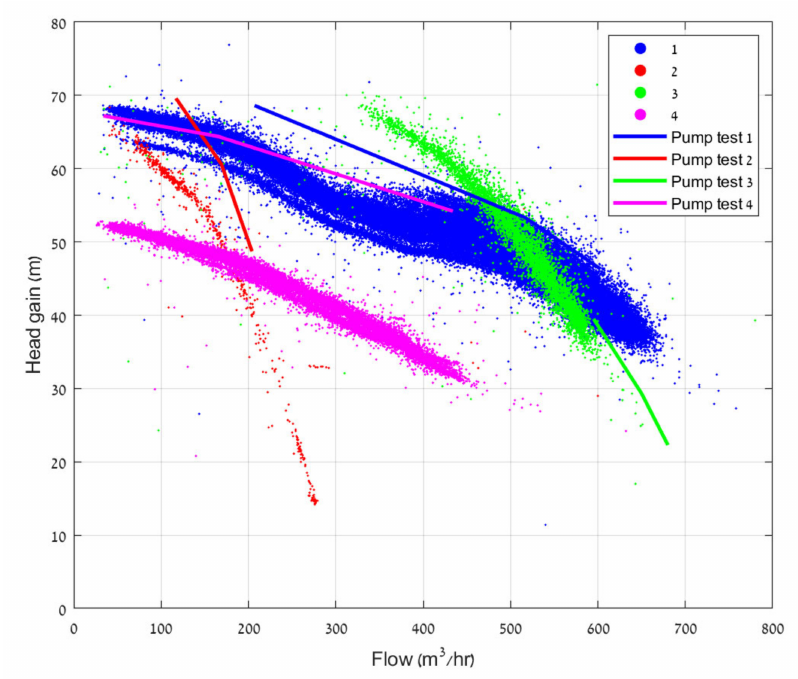
Figure 7. Individual pump curves for the test case pumping